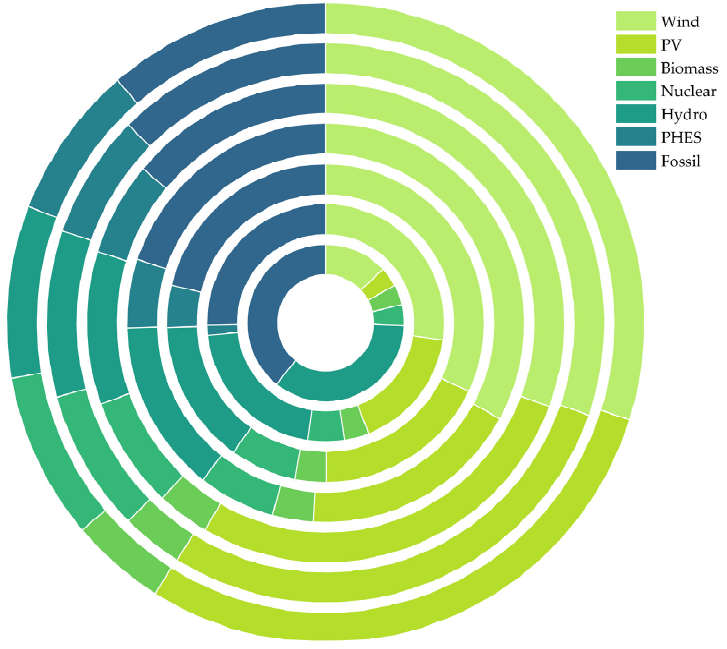
Figure 9. The proportion of various power generation installed capacity (The rings from inner to outer are 2020Ref, 2025Policy, 2030Policy, 2030RES, 2050LRES, 2050MRES, and 2050HRES.)